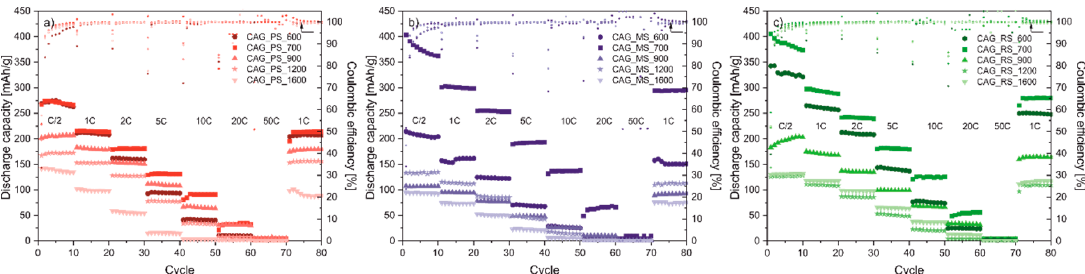
Figure 3. The rate capability of the ( a ) CAG_PS, ( b ) CAG_MS, and ( c ) CAG_RS based anodes at various C rates.